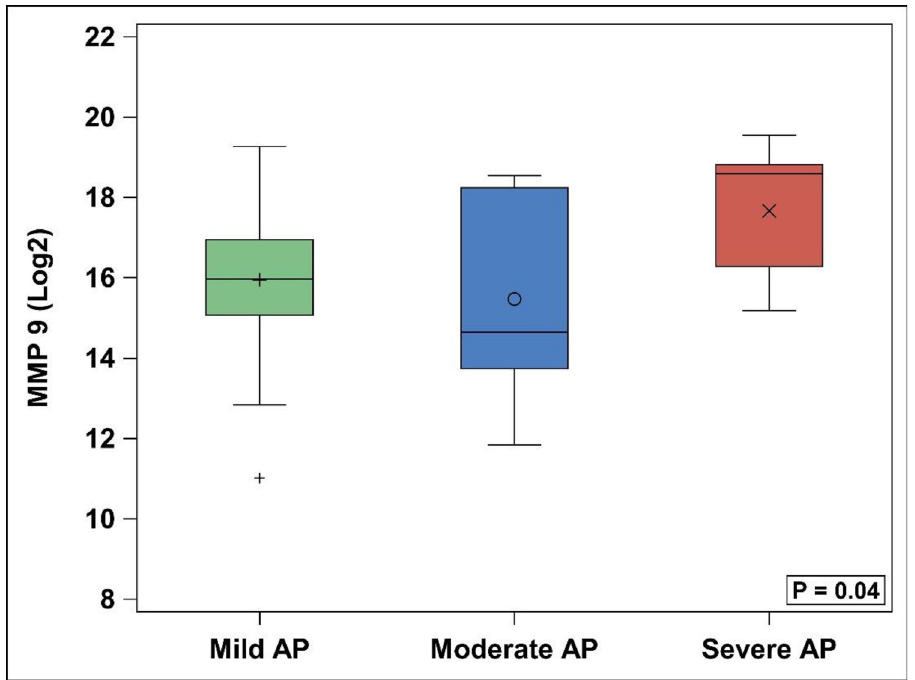
Fig 1. MMP-9 levels. AP = acute pancreatitis. MMP = matrix metalloproteinase.